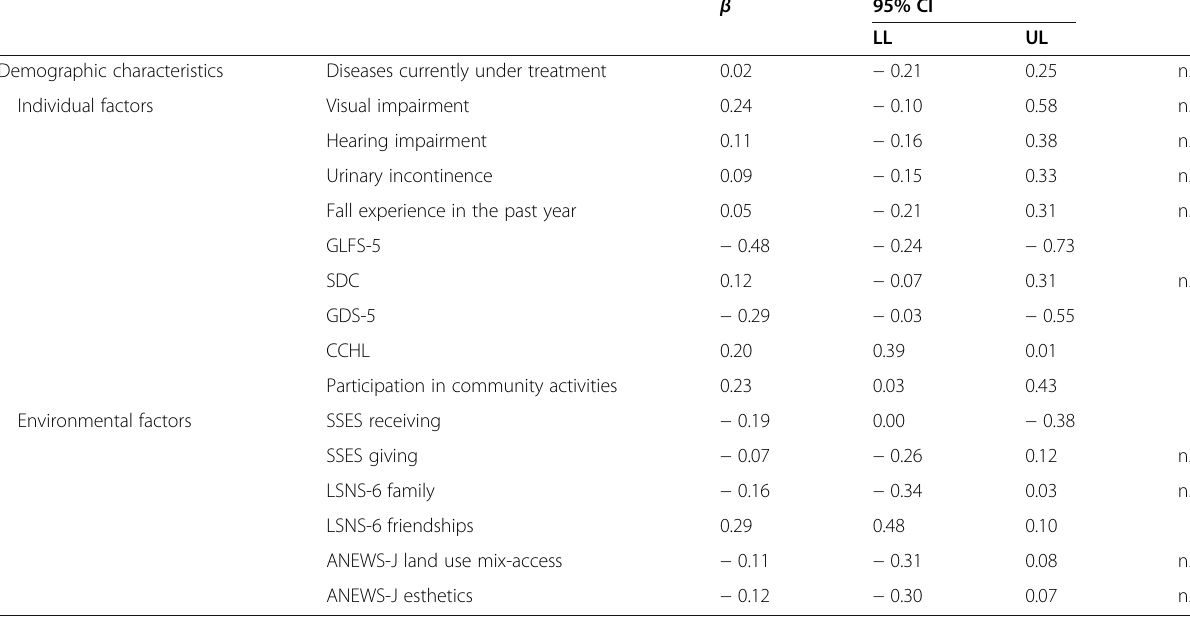
Table 3 Demographic, individual, and environmental factors associated with life-space mobility in negative multivariable binomial regression analysis